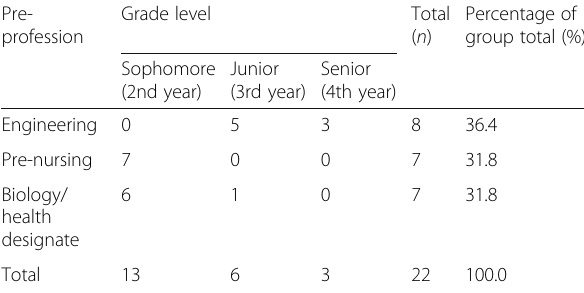
Table 3 Number of participants by major and grade level Pre-